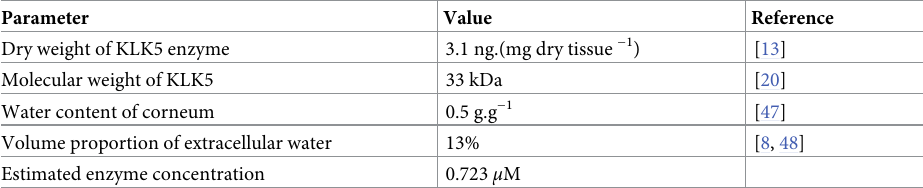
Table 2. Parameters used to determine the concentration of KLK5 enzyme.